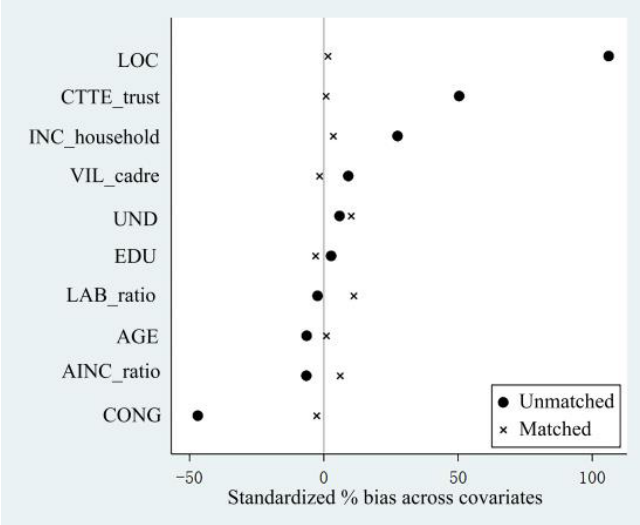
Figure 4. Standardized bias across covariates.